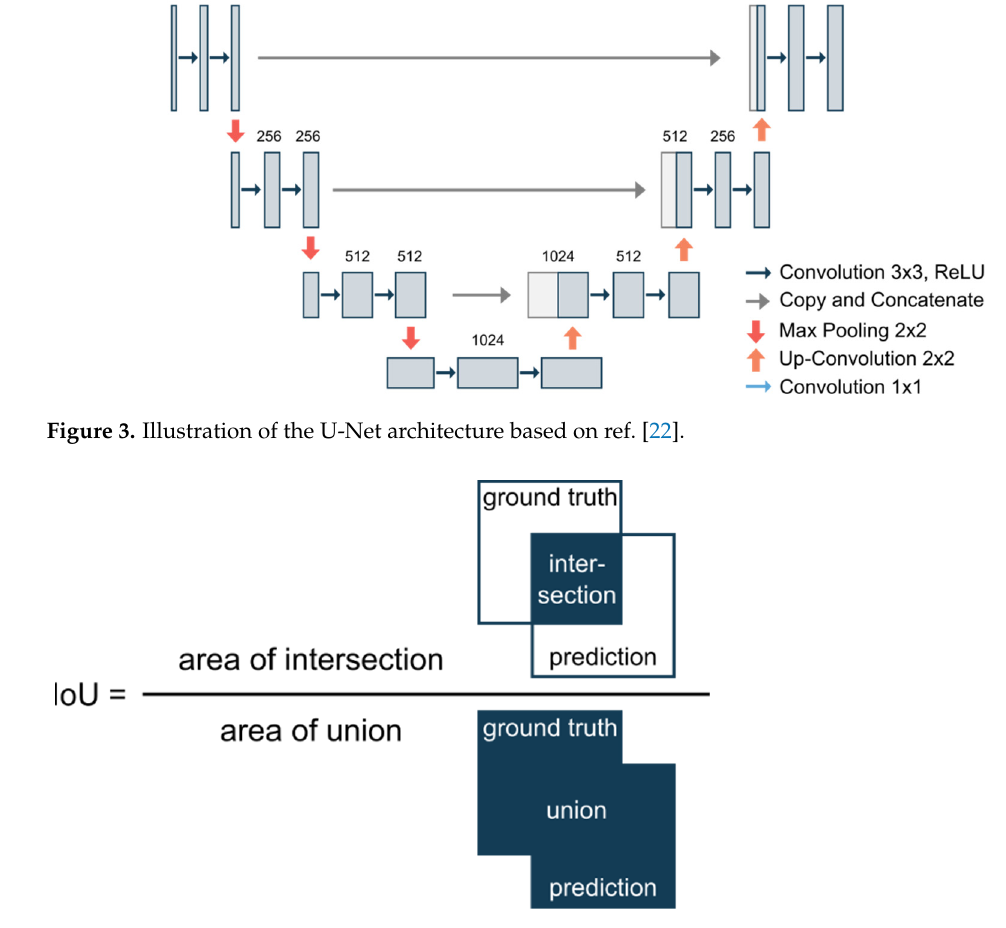
Figure 4. Illustration of the computation of the segmentation metric IoU (Intersection over Union). The U-Net was implemented in Python using TensorFlow 2.5.0 and trained on a NVIDIA GeForce RTX 3080